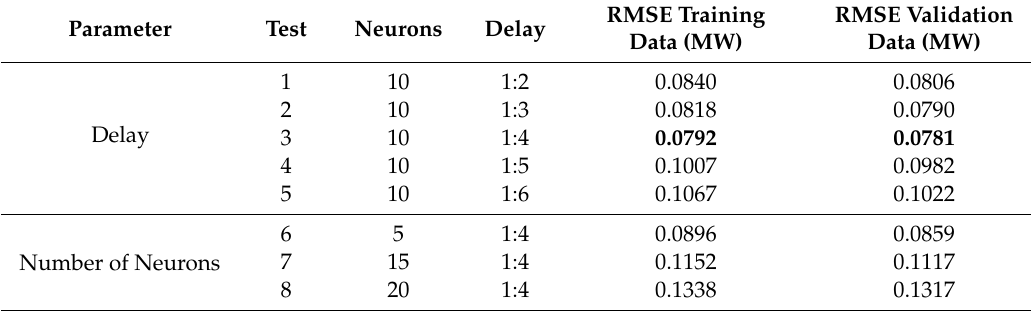
Table 3. Structure design test for option 1.